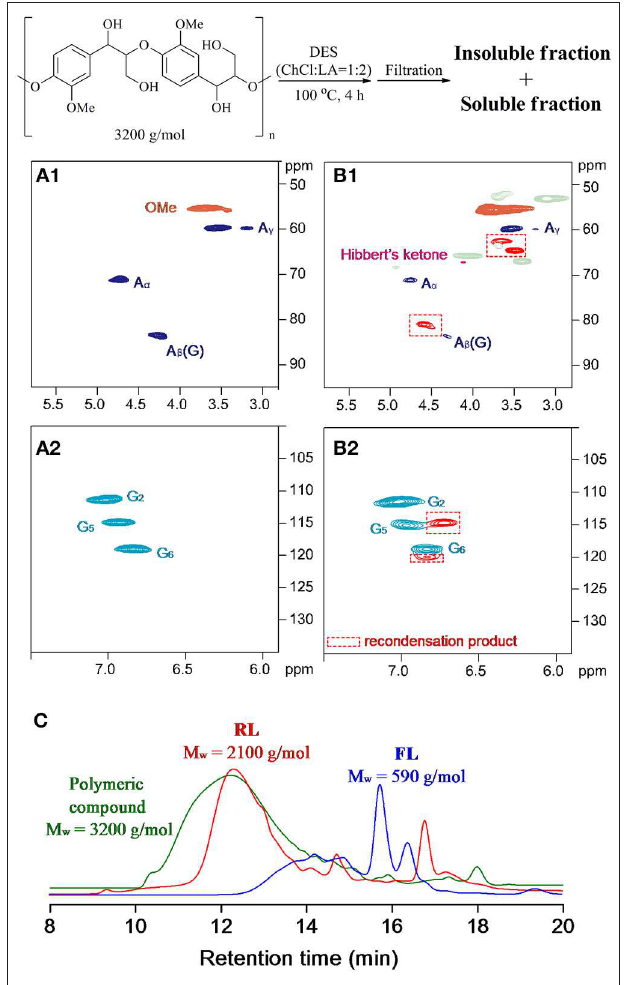
FIGURE 4 | Two-dimensional (2D) heteronuclear single quantum coherence spectroscopy (HSQC) spectra of (A) synthetic lignin polymeric compounds and (B) insoluble fraction after deep eutectic solvent (DES) treatment. (C) The molecular weight distribution.